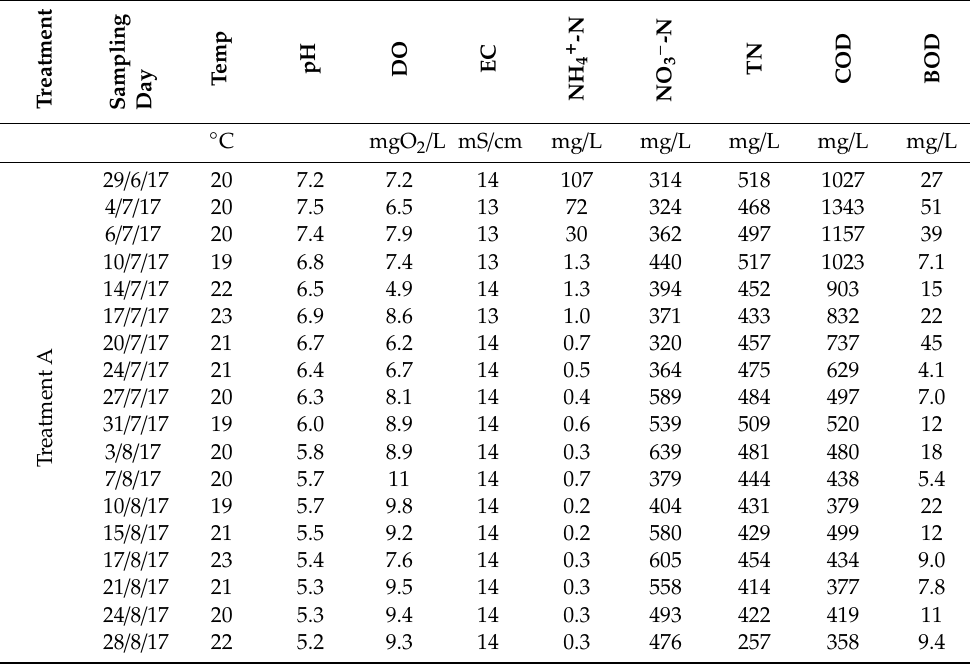
Table A2. Mean values of physicochemical, organic, and nitrogen compounds concentrations during the second stage of the experiment (COD depletion